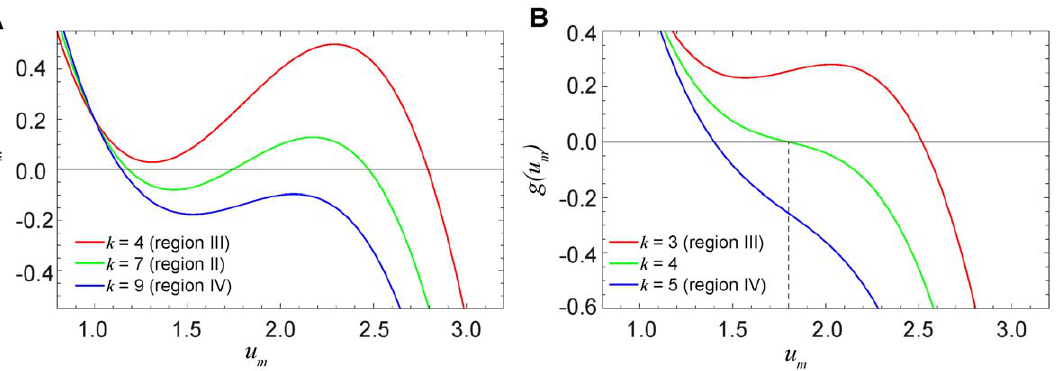
Figure 8. The typical form of functions g ( u m ) in different regions of the parameter plane. Functions g ( u m ) are shown below (A, D ~ 0 : 1 ) and above (B, D ~ 0 : 32 ) the cusp point. The green curve in part (B) corresponds to the boundary between regions III and IV, where the front propagation velocity vanishes. The other parameters are r 1 ~ 1 , r 2 ~ 1 : 4 and r 3 ~ 3 .